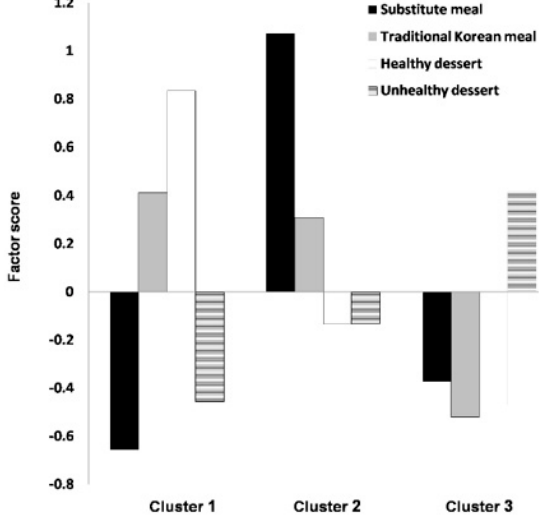
Figure 1. Mean values of centered cluster subjects.